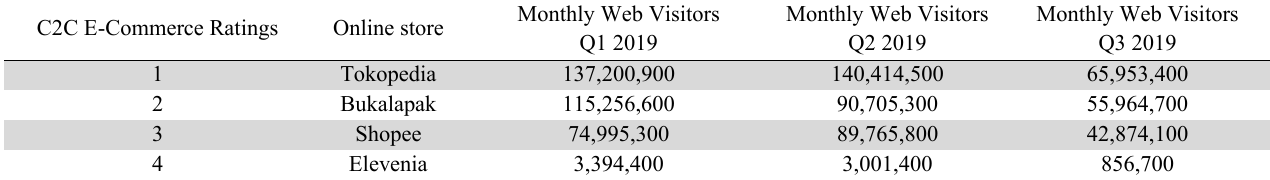
Map of C2C E-Commerce Competition in Indonesia Q1 2019 - Q3